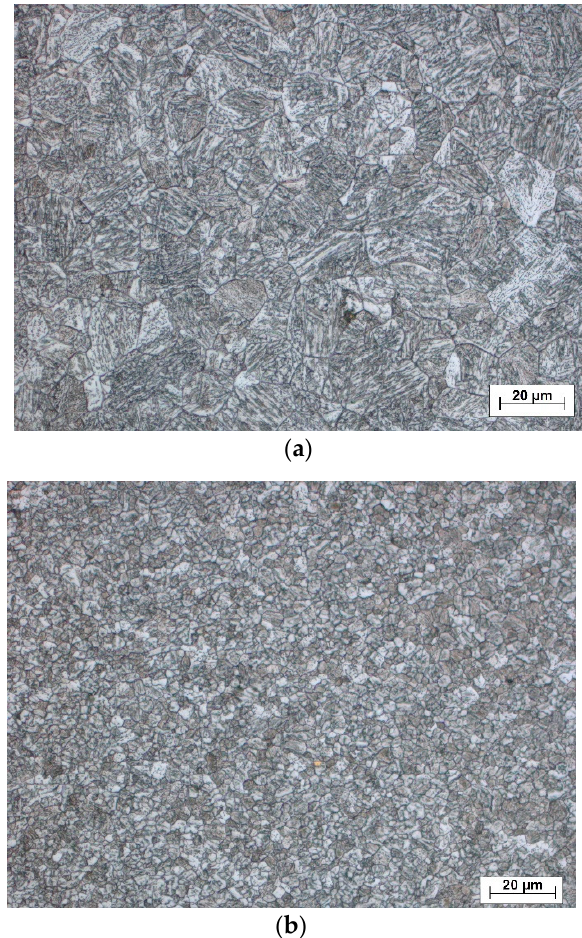
Figure 7. Microstructure of the individual subzones of the heat-affected zone (HAZ): ( a ) coarse-grain HAZ (CGHAZ) and ( b ) fine-grain HAZ (FGHAZ).